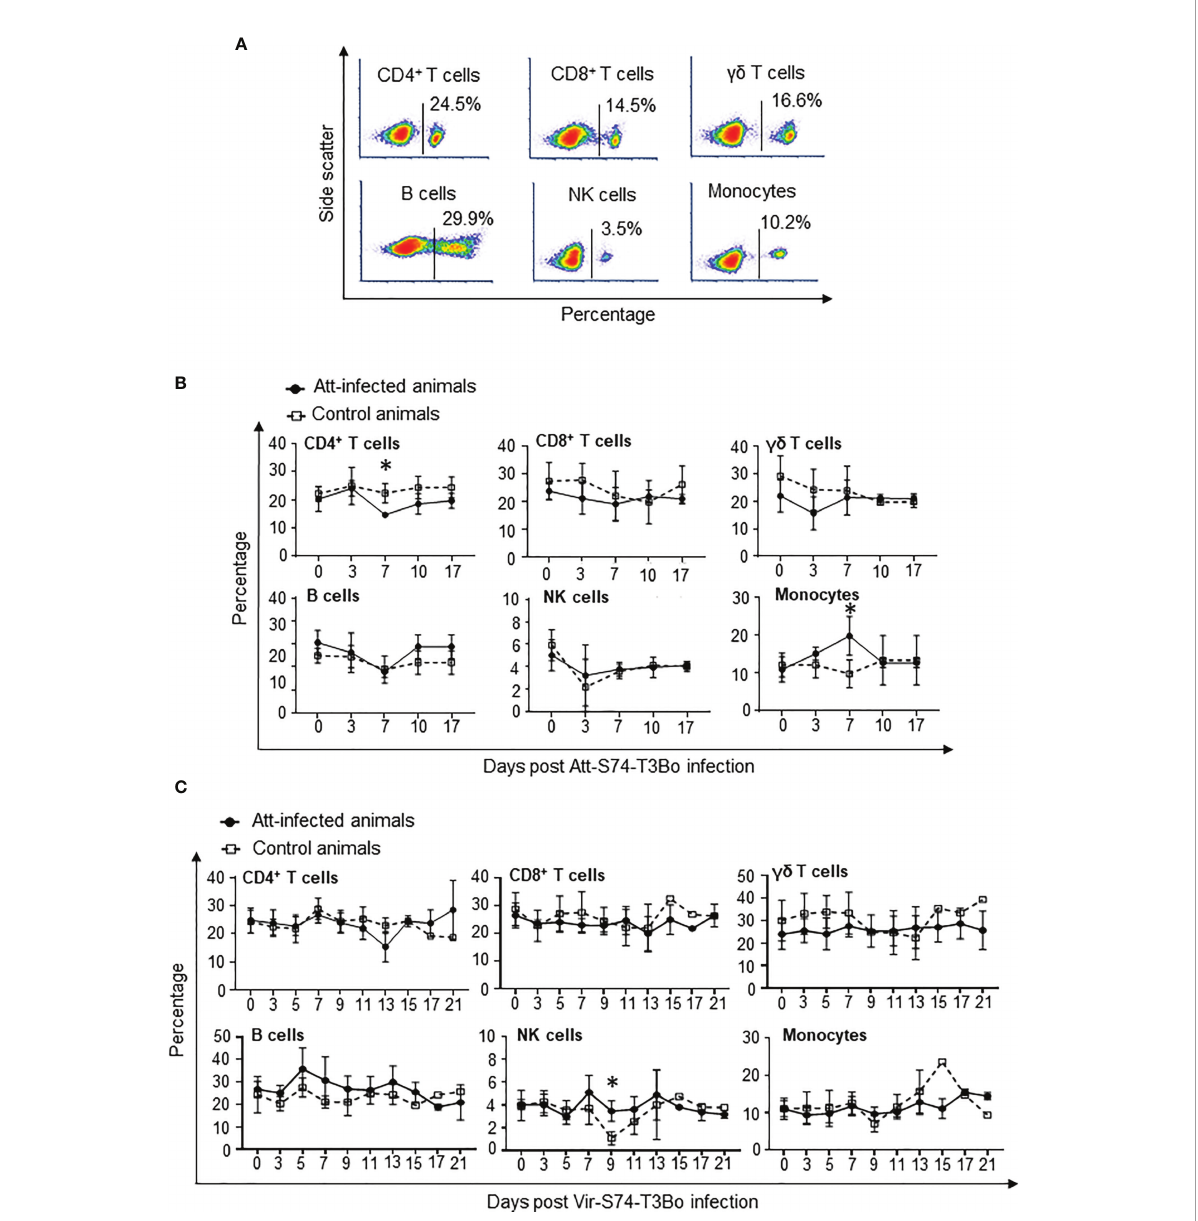
FIGURE 4 Kinetics of peripheral blood mononuclear cells (PBMC) after infections with the in vitro culture attenuated B. bovis strain Att-S74-T3Bo and the virulent B. bovis strain Vir-S74-T3Bo. Flow cytometric analysis showing PBMC from a normal, uninfected representative calf stained for CD4 + T cells, CD8 + T cells, gd T cells, CD14 + monocytes, and CD335 + natural killer cells (NK) (A) . Kinetics of CD4 + T cells, CD8 + T cells, gd T cells, B lymphocytes, CD14 + monocytes, and CD335 + NK cells after Att-S74-T3Bo infection (B) . Kinetics of CD4 + T cells, CD8 + T cells, gd T cells, B lymphocytes, CD14 + monocytes, and CD335 + NK cells following Vir-S74-T3Bo infection (C) . Att infected animals (n=3). Control animals (n=3; two animals of the control group were humanely euthanized at days 13 and 14 after Vir-S74-T3Bo inoculation due to the severity of the disease). *